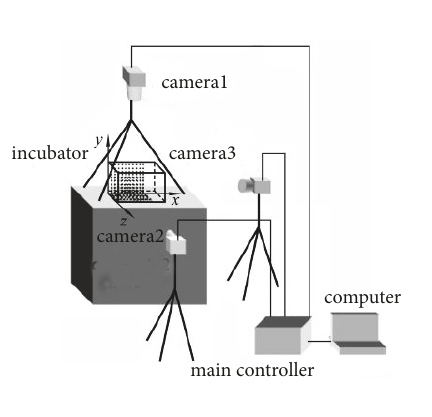
Figure 1: Schematic of the experimental system.